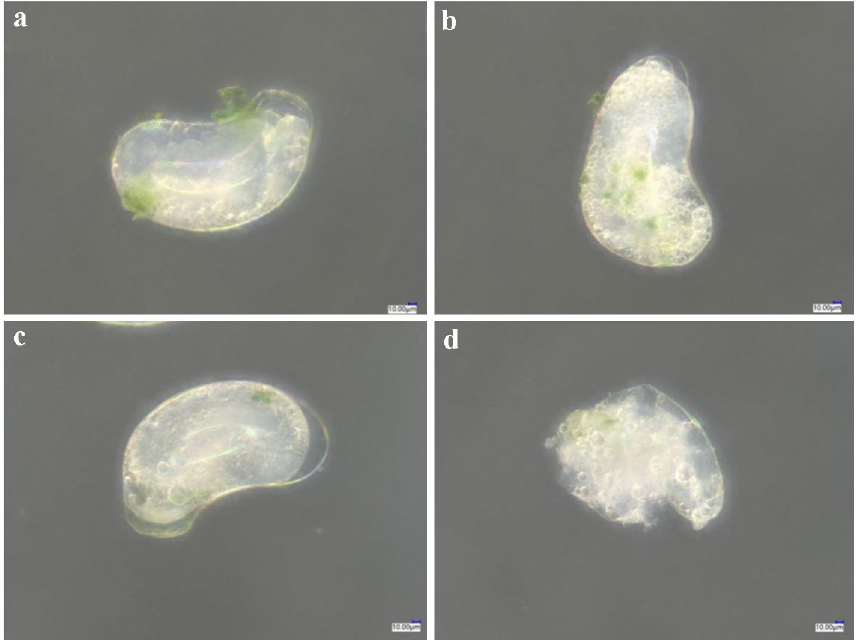
Figure 2. The effect of spirotetramat on external morphology of living 0-h-old eggs of F. occidentalis . ( a ) External morphology of live 0-h-old eggs of normal developing thrips; ( b ) developmentally deformed eggs after spirotetramat treatment; ( c ) eggs with shrunken oocytes after spirotetramat treatment; ( d ) eggs with apical rupture of the eggshell after spirotetramat treatment.